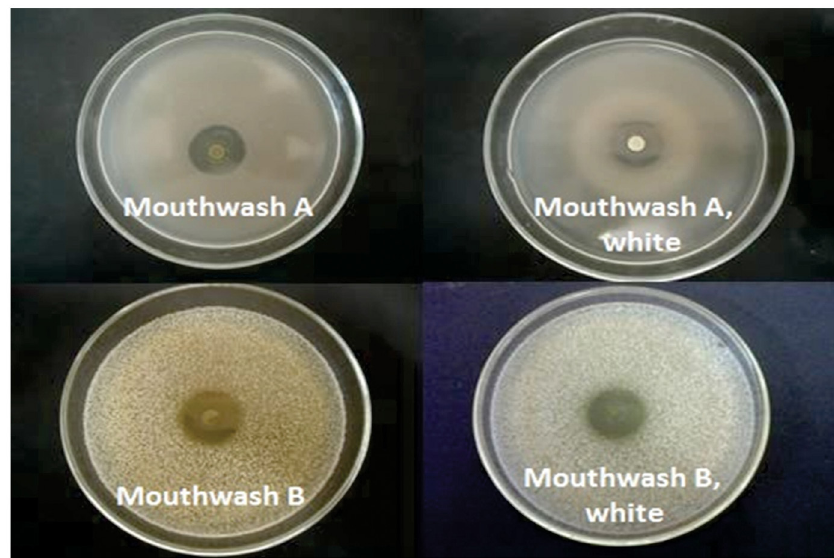
FIGURE 2 -Inhibition halos for mouthwash A and white; for mouthwash A to S. mutans . Inhibition halos for mouthwash B and white; for mouthwash B to C. albicans